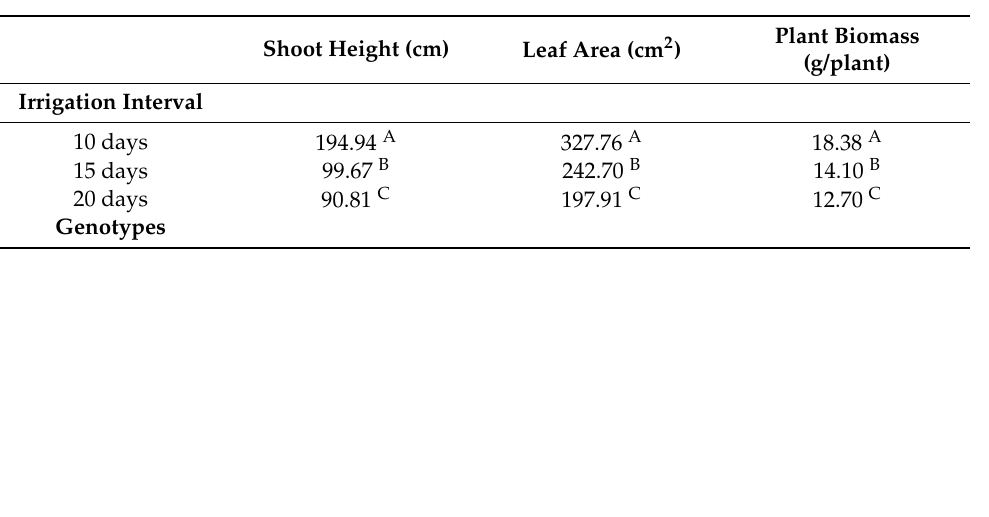
Table 3. Growth criteria of five maize genotypes as affected by normal (10 days), mild (15 days), and severe (20 days) water stress at the vegetative stage. Means within the same column distinguished by different letters differ significantly according to the Tukey’s posthoc HSD test at p =